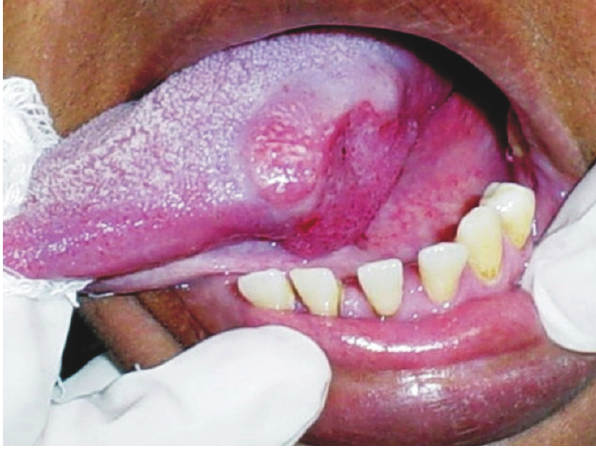
Figure 13 - Oral squamous cell carcinoma on the dorsum of the tongue and floor of the mouth.